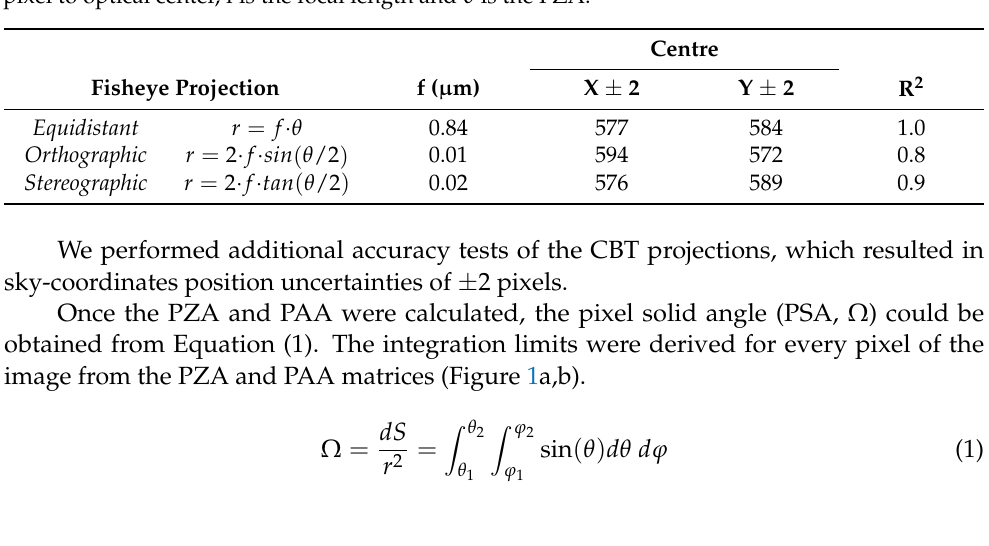
Figure 1. Sky dome projection on our SONA sky-camera: ( a ) Pixel Zenith Angle; ( b ) Pixel Azimuth Angle; ( c ) Pixel Solid Angle. Table 1. Regression fit results for different fisheye projections, where r represents the radius from the pixel to optical center, f is the focal length and θ is the